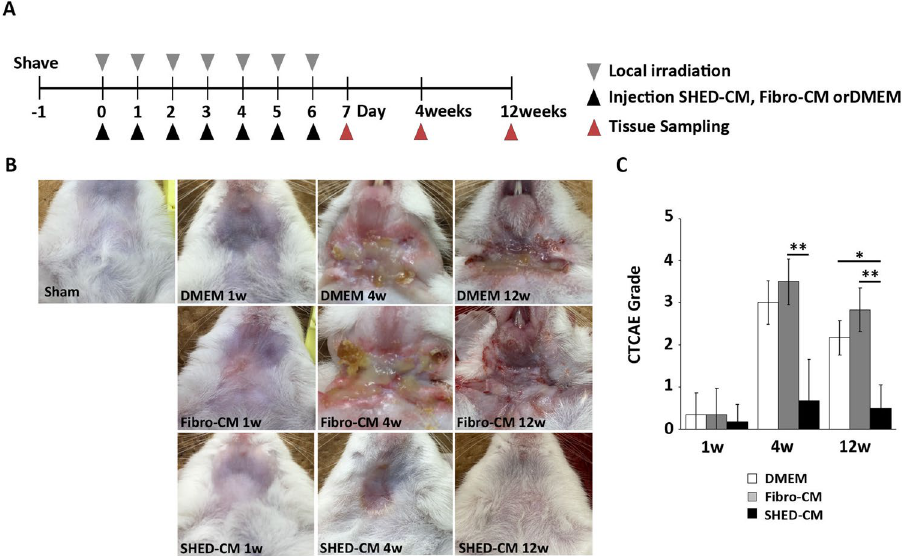
Figure 1. Intravenous administration of SHED-CM improves radiation-induced skin injury. ( A ) Experimental protocol. Mice were irradiated locally in the neck with 5 Gy for 7 consecutive days. SHED-CM, Fibro-CM, or DMEM was intravenously administered after each irradiation. ( B ) Representative optical images of skin injury at 24 h, 4 weeks, and 12 weeks after the first irradiation. ( C ) The level of the skin injury was evaluated based on the Common Terminology Criteria for Adverse Events scale as described in Methods. Comparisons between groups were analyzed using a Kruskal–Wallis test/Dunn’s multiple comparison test (* p < 0.05, ** p < 0.01). CM, conditioned medium; Fibro, fibroblast; SHED, stem cells from human exfoliated deciduous